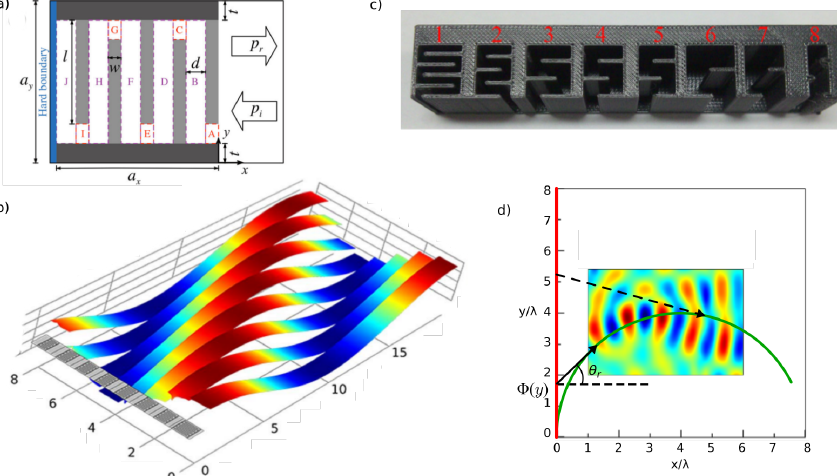
Figure 7. Shaping the reflection field, from [22,23]. The unit cell is easily parametrized ( a ) to obtain a phase shift profile ( b , colors indicate the phase of the reflected field when a plane wave is incoming) combining different cells in an array ( c ). An arbitrary shape can be obtained, imposing different phase shift profiles, φ ( y ) , to the reflected field ( d